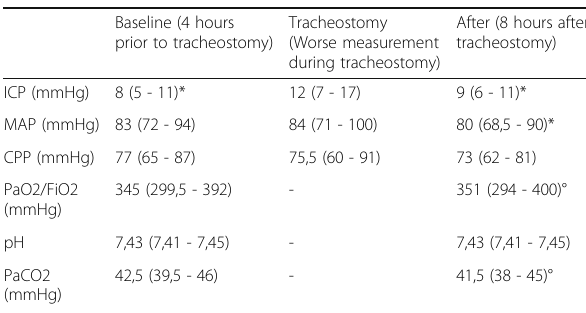
Table 49 (abstract A130).